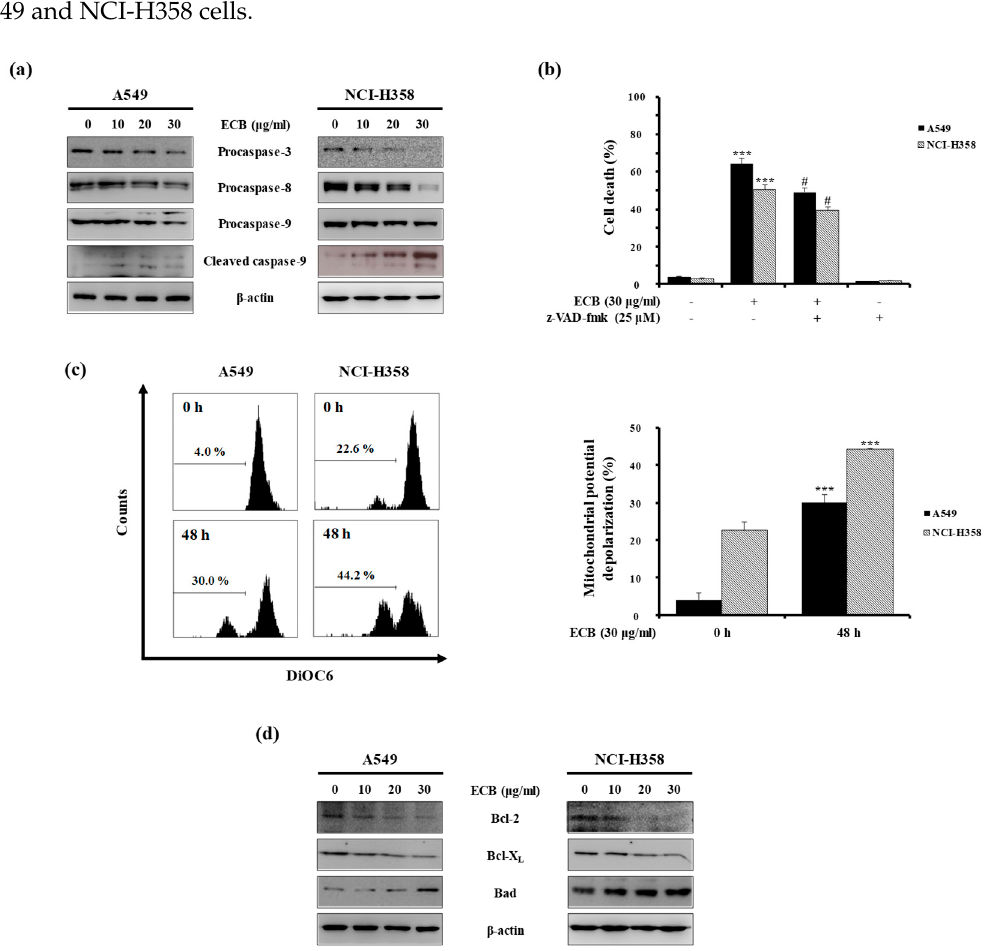
Figure 2. Effects of ECB on apoptosis-related proteins. ( a ) A549 and NCI-H358 cells were treated with Figure 2. E ff ects of ECB on apoptosis-related proteins. ( a ) A549 and NCI-H358 cells were different doses of ECB for 48 h. Western blot analysis was conducted to determine the protein